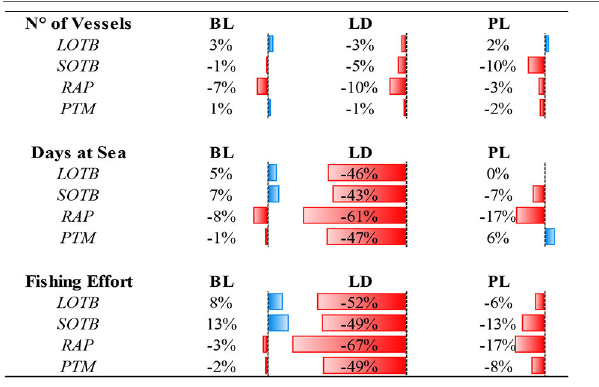
TABLE 1 | Percentage differences disaggregated per fishing gears (LOTB, SOTB, RAP, and PTM), between 2019 and 2020 during the three periods (BL: